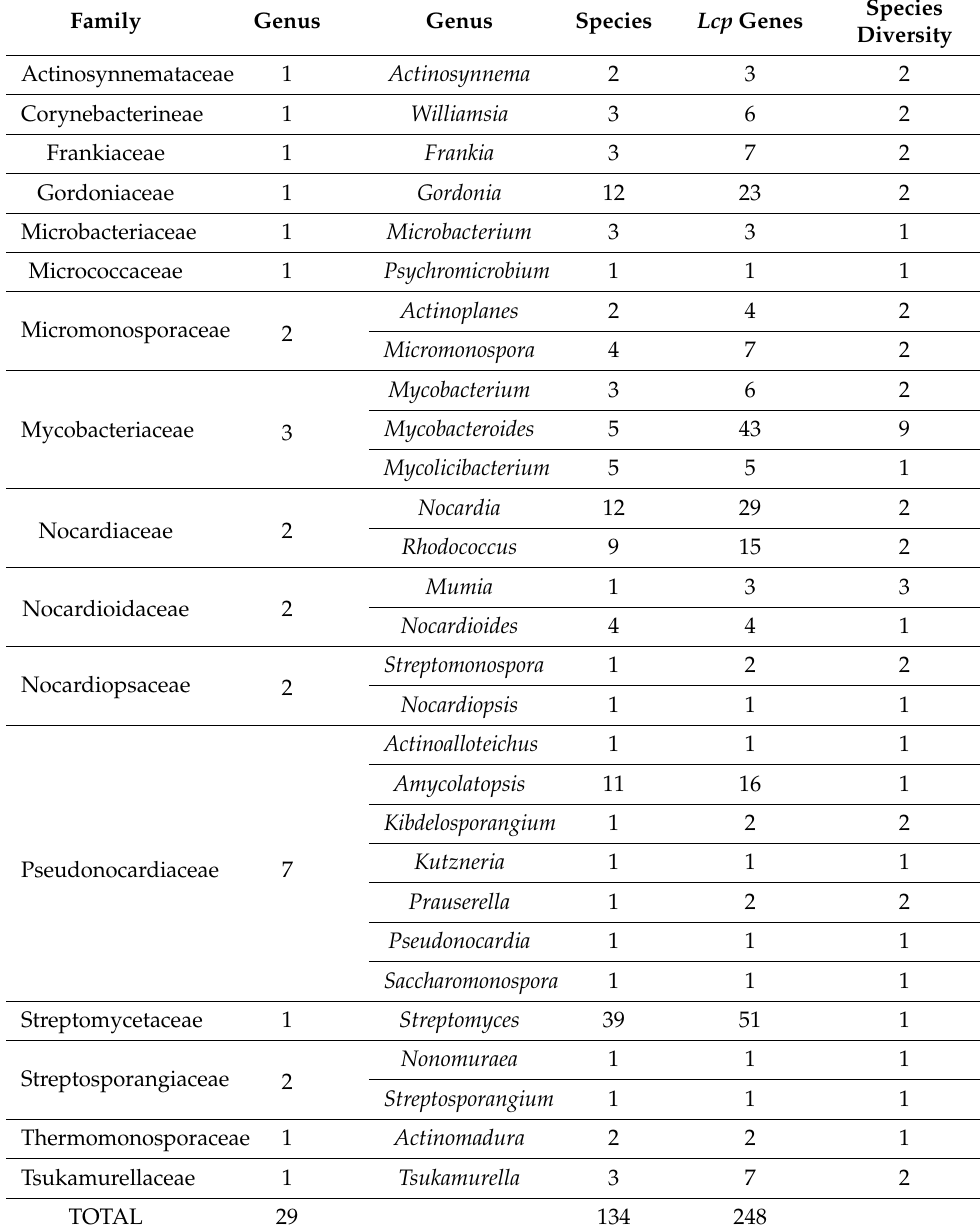
Table 2. Diversity of Actinobacteria with DUF2236 domain containing lcp genes in GenBank